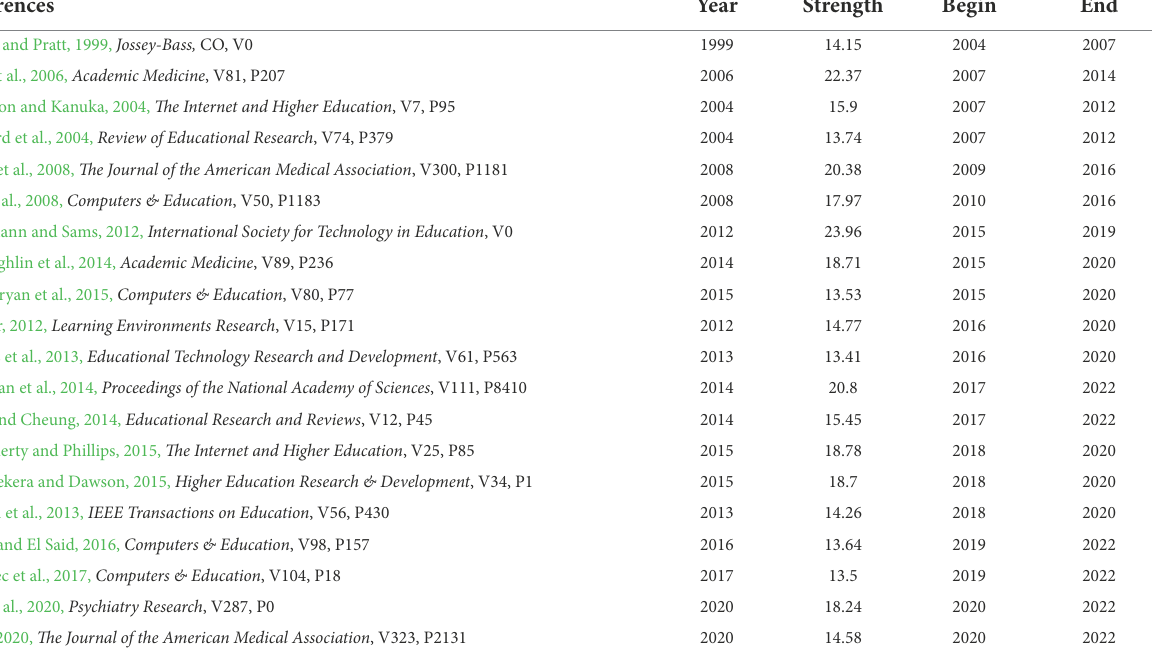
TABLE 8 Top 20 references with strongest citation bursts.